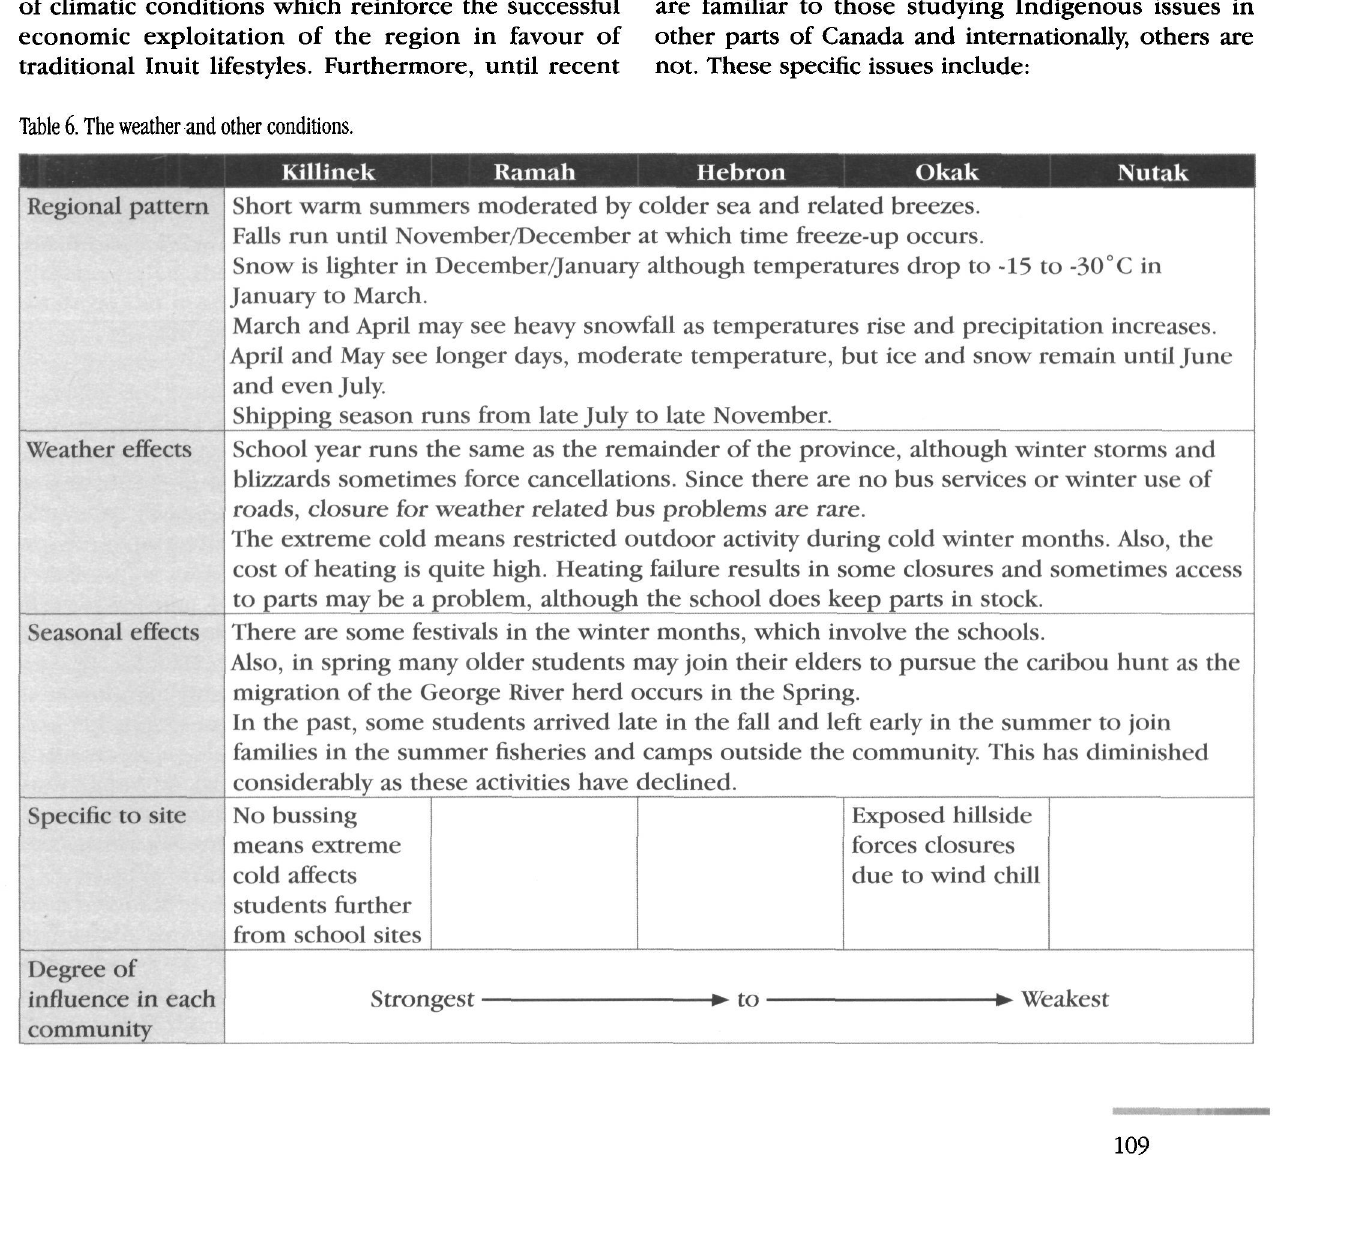
Table 6. The weather and other conditions. Killinek Raman Regional